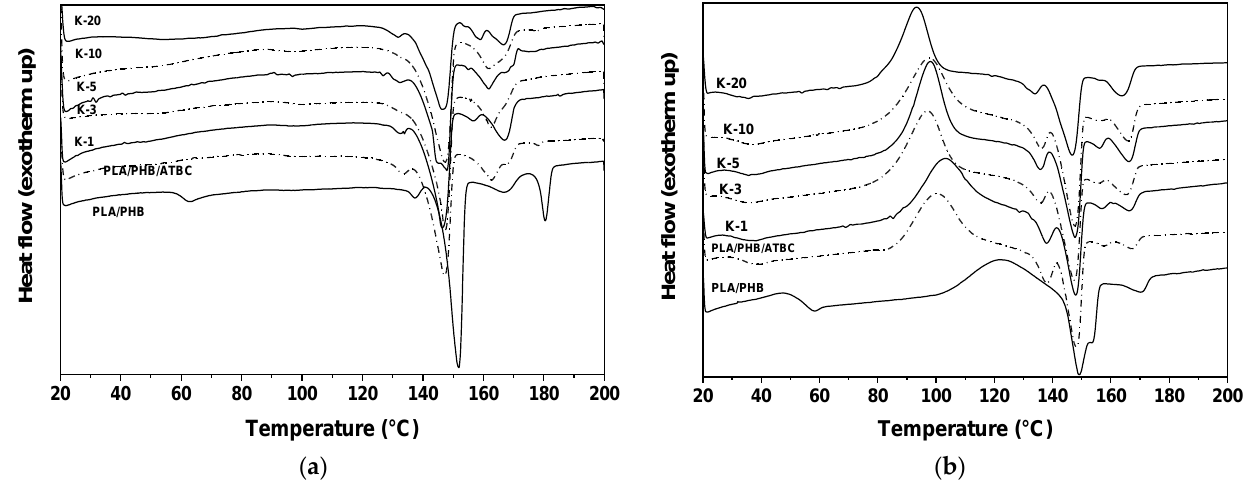
Figure 3. DSC ( a ) first and ( b ) second heating records of PLA/PHB and PLA/PHB/ATBC neat blends and their keratin composites with different keratin contents varying from 1 to 20 wt%. Table 1. Parameters obtained from DSC heating records of PLA/PHB and PLA/PHB/ATBC neat blends and their keratin composites with different keratin contents varying from 1 to 20 wt%.